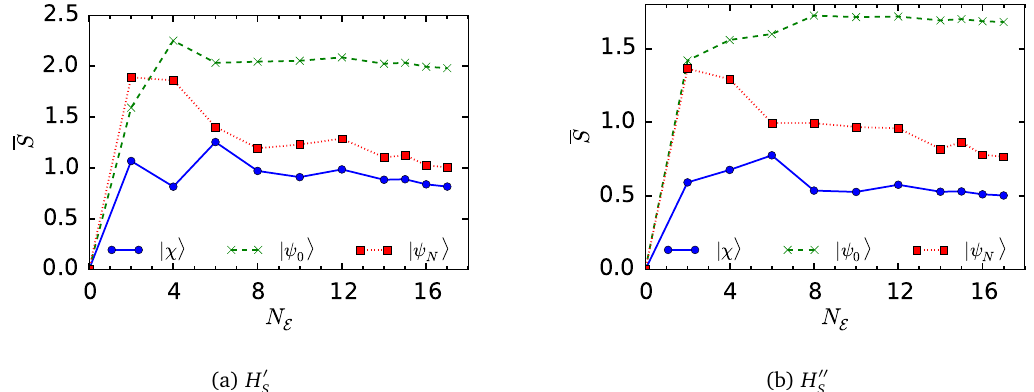
Figure 9: Effect of an S z symmetry breaking (additional) term (indicated below the panel) tot on the time-averaged entropy S ( 180,20 ) , as a function of the environment size N (cid:69) . The CS is strongly coupled to the environment with strength I = 20 J , while the intra-environment S strength is fixed to KN (cid:69) ( N (cid:69) − 1 ) = 24 / 5 J . The dipolar coupling J xx and transverse field h x S S are both set to J . S